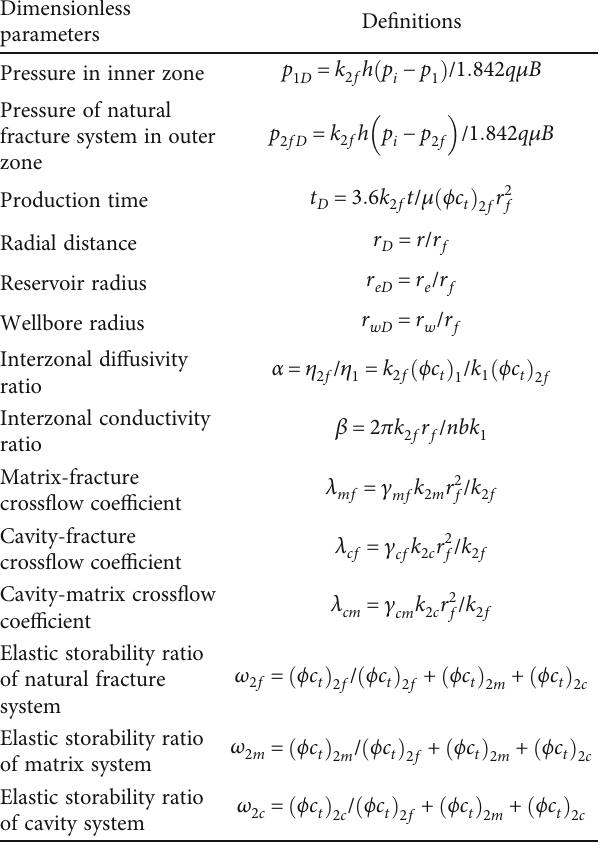
Table 1: De fi nitions of dimensionless